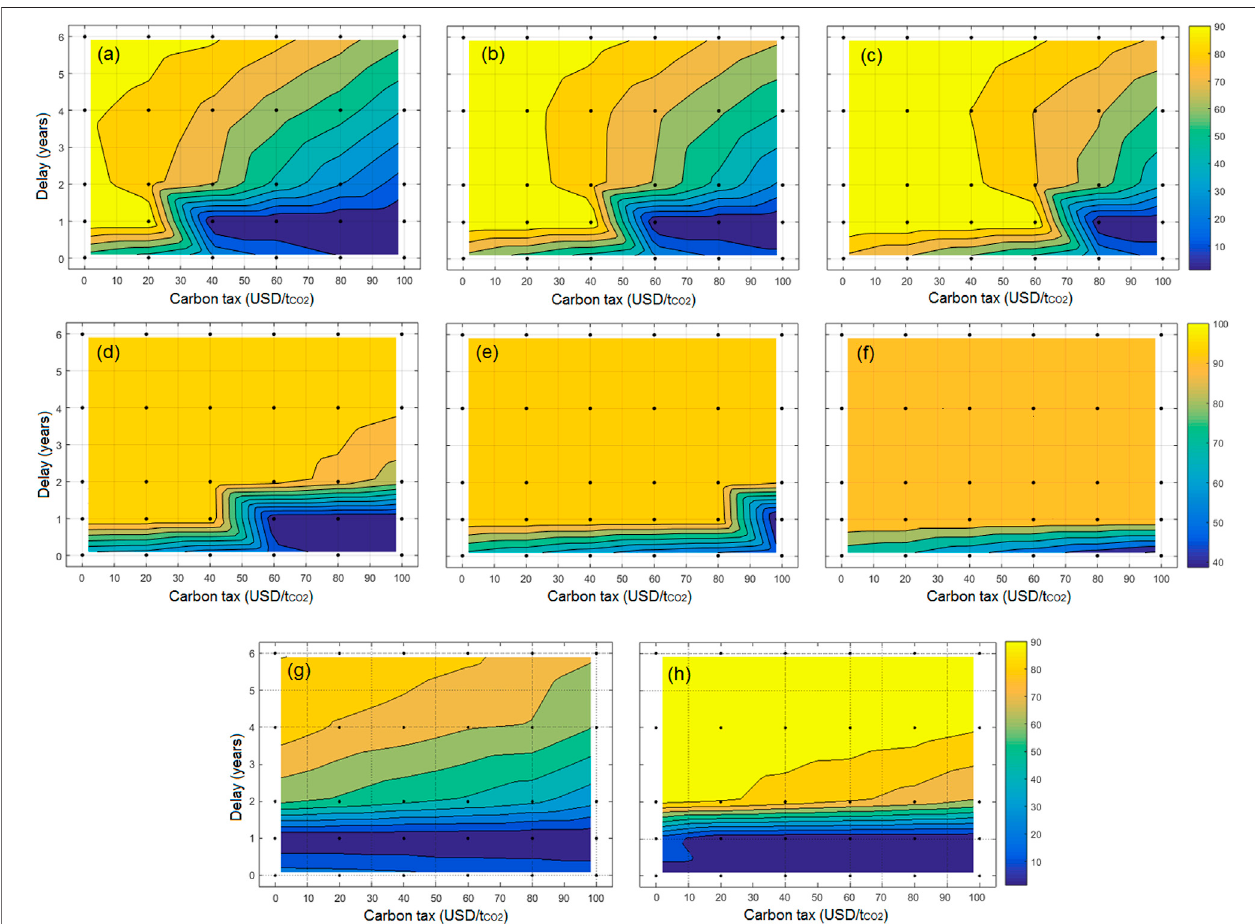
FIGURE8 | Plots ofselected contours ofthe likelihood of loss (in %) ofthe utility systems asa function of the delay in entrance ofoperation and thecarbon tax. For scenario 2 and i = 5%: (A) 500 USD/t CO2 , (B) 1,000 USD/t CO2 , (C) 1,500 USD/t CO2 . For scenario 2 and i = 15%: (D) 500 USD/t CO2 , (E) 1,000 USD/t CO2 , (F) 1,500 USD/t CO2 . For scenario 4 and (G) i = 5% or (H) i =